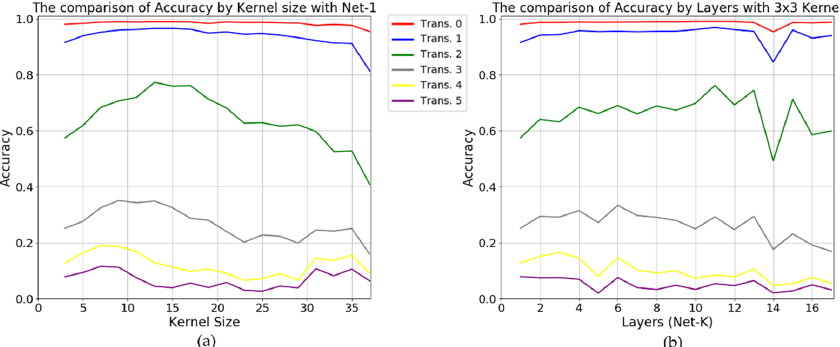
Figure 6. The accuracy of the networks tested with N-pixel translated (depicted by Trans. N) images. ( a ) for the deep networks with varying convolutional layers of up to 17 with the same 3 × 3 kernel size, ( b ) for the Net-1 network with varying kernel sizes of up to 37.